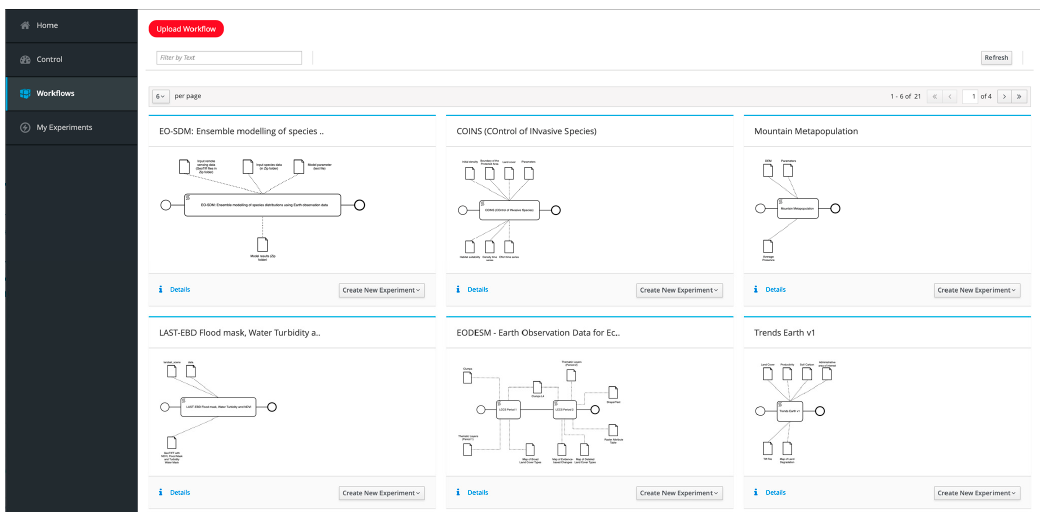
Figure 9. VLab Web Application for Model Publication and Sharing (https://vlab.geodab.org/).